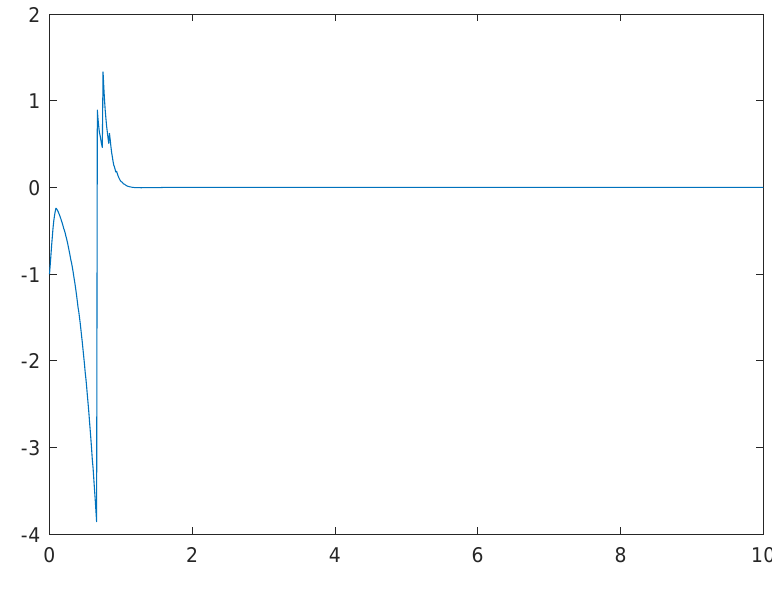
Figure 1. Computer simulation of the solution x ( t ) of Equation (48).